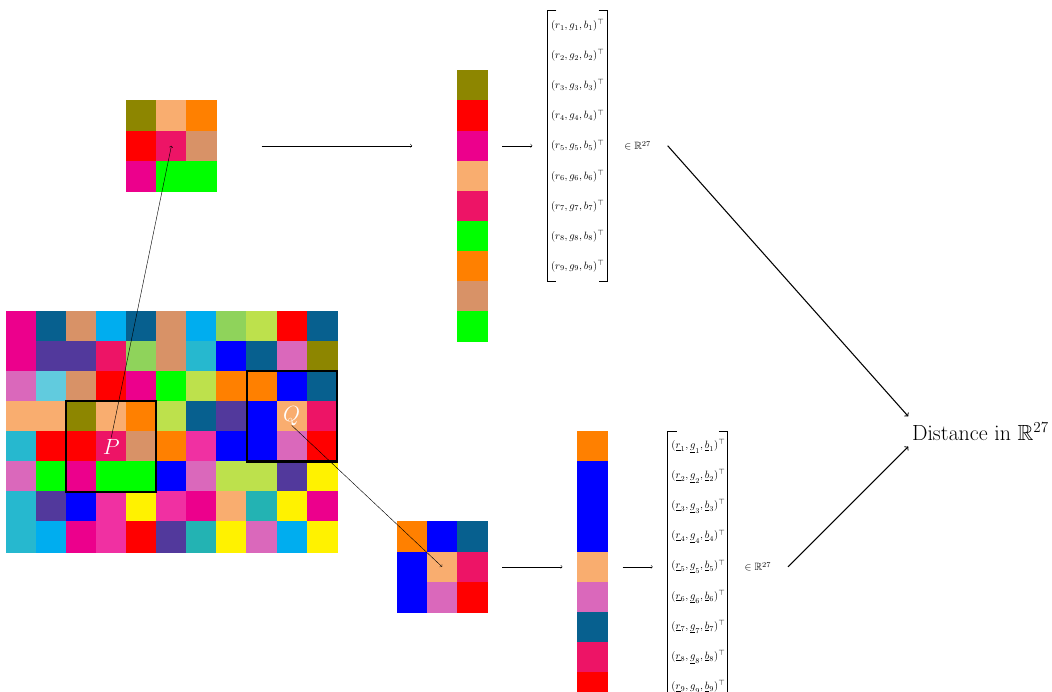
Figure 2. The definition of a new distance between pixel P and pixel Q in a colour image. We select a neighbourhood for each pixel, here a 8-neighbourhood, and consider the components of each pixel in the neighbourhood in some fixed colour space, in this example the RGB space. For the pixel P we have the vectors ( r i , g i , b i ) , i = 1,...,9, while for the pixel Q the vectors ( r i , g , b i ) , i = 1,...,9. Finally, we collect all the entries and form two vectors V P , V Q , and compute some distance, i e.g., the Euclidean one, between these two